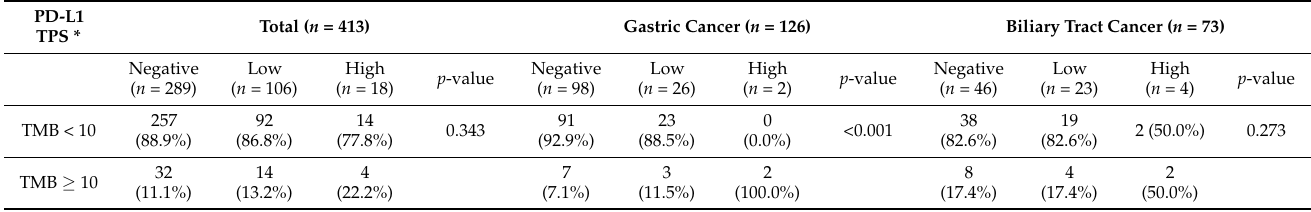
Table 3. Correlation of PD-L1 tumor proportion score (TPS) with tumor mutation burden (TMB) according to primary tumor.